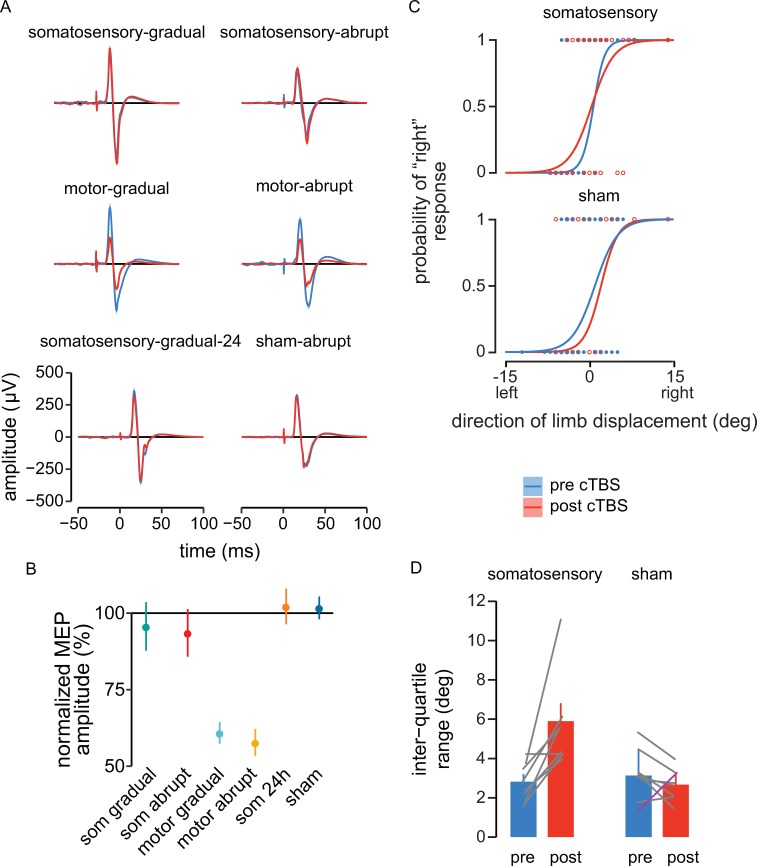
Excitability of motor cortex is not affected by cTBS over somatosensory (“som”) cortex, whereas cTBS over motor cortex suppresses its excitability.cTBS to somatosensory cortex decreases perceptual acuity. (A) Mean time series of MEPs recorded from biceps brachii pre- (blue) and post-cTBS (red) from a representative participant. The TMS pulse occurs at t = 0 ms. The shaded regions are ±SEM across 20 MEPs. (B) Mean change in amplitude of MEPs recorded post-cTBS (expressed as a percentage of pre-cTBS MEPs). Error bars give standard error across participants. (C) Psychometric fit to perceived limb position, showing performance of a representative participant before and after cTBS and sham stimulation. (D) Interquartile range pre- and post stimulation. Participants showed a decrease in perceptual acuity after suppression of somatosensory cortex. Error bars show standard error across participants. Data used to generate the figures in (B) and (D) can be found in S2 Data. cTBS, continuous theta-burst transcranial magnetic stimulation; MEP, motor-evoked potential; TMS, transcranial magnetic stimulation.